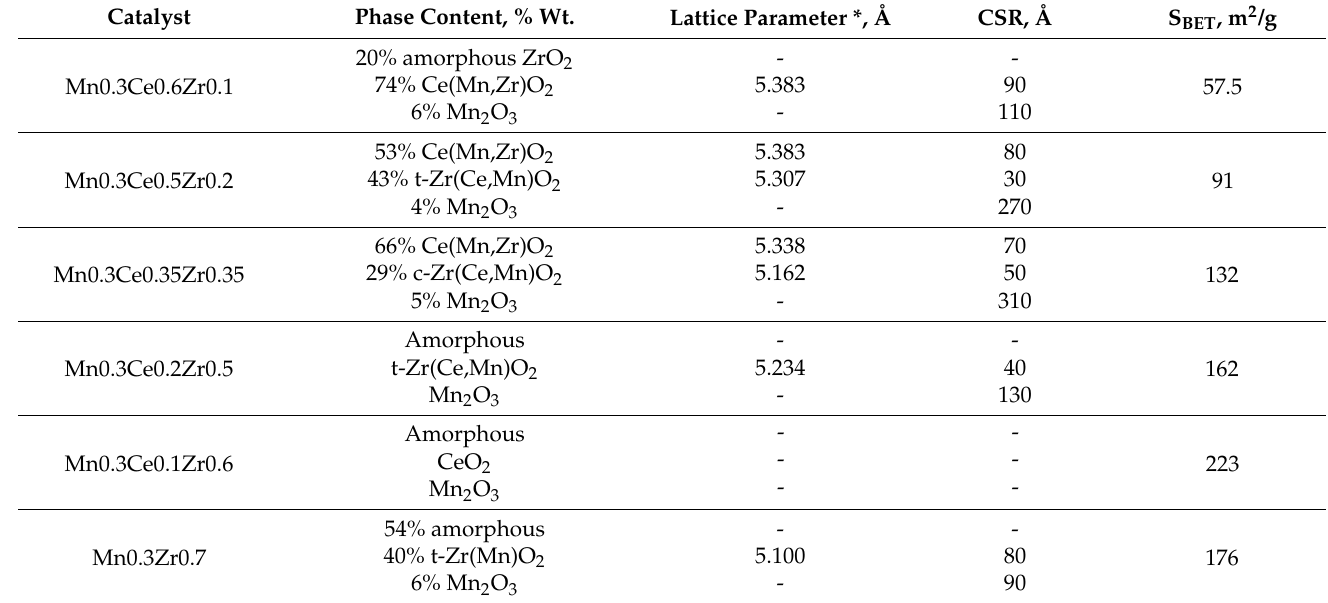
Table 2. Phase composition, lattice parameter of solid solution, CSR, and surface area of Mn0.3(Zr,Ce)0.7 catalysts.